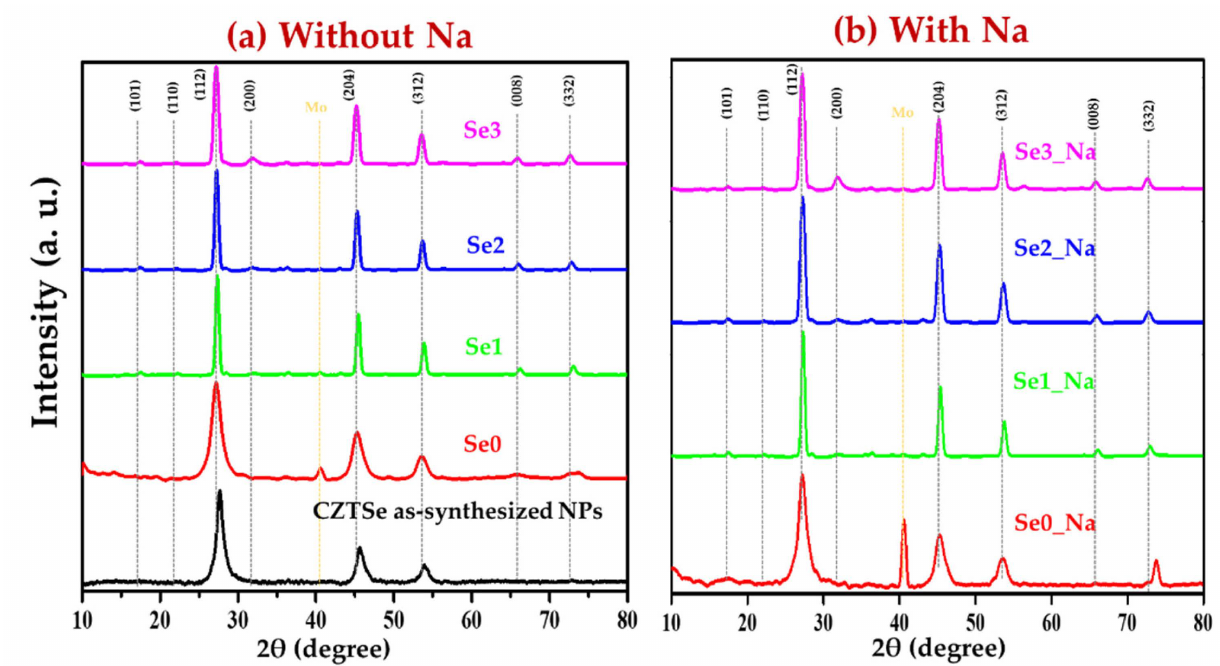
Figure 2. XRD pattern of CZTSe thin films ( a ) without and ( b ) with sodium